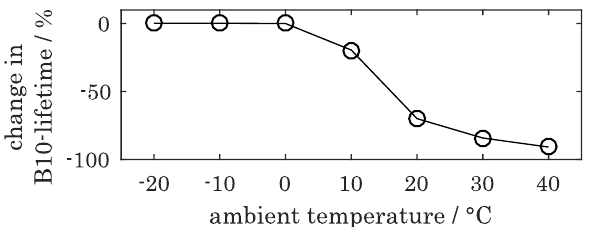
Figure 14: B 10-lifetime changes of bearings for differ- ent ambient temperatures, Load: 30 t, Wind speed: Beaufort